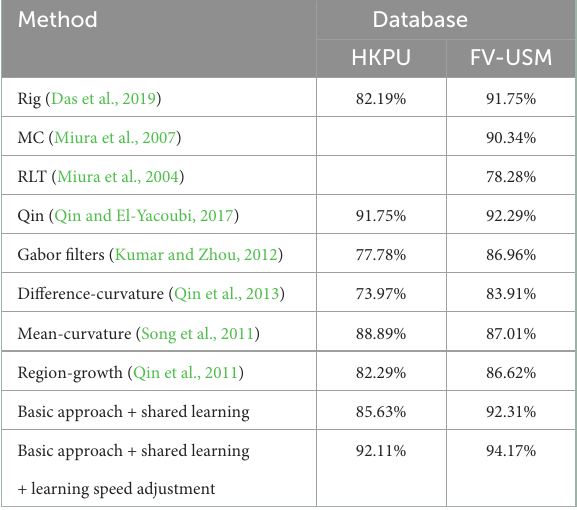
TABLE 8 Performance comparisons with state-of-art